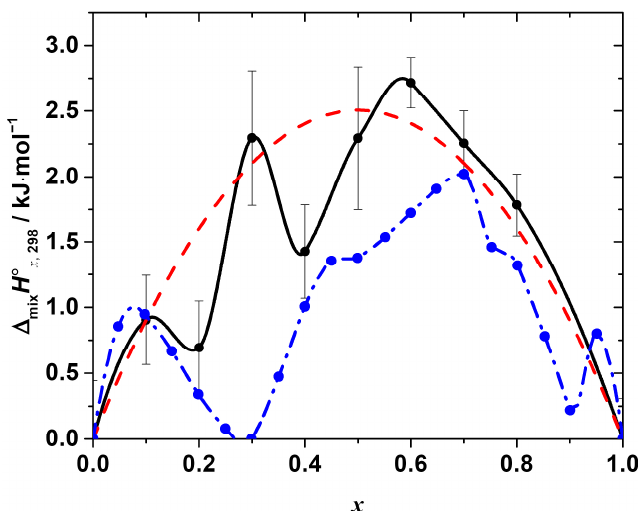
* The numbers following the symbol ± correspond to the values of the expanded uncertainties U c = k · u c determined from a combined standard uncertainty u c and a coverage factor k = 2, corresponding to 95% level of confidence. Expanded uncertainties U c ( T ) = 0.04 K, U c ( p °) = 4 kPa.